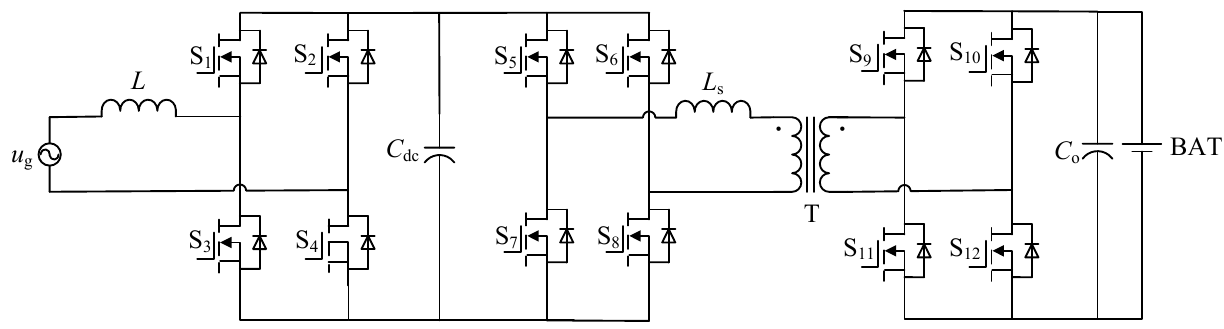
Figure 4. A two-stage topology composed of PWM converter and dual-active-bridge